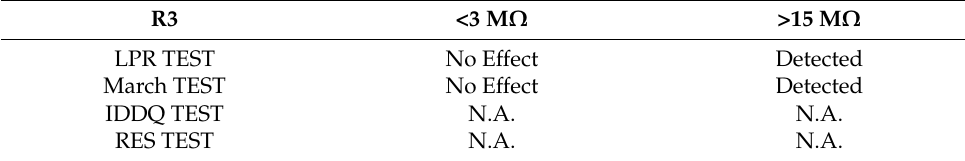
Table 7. Summary of the effectiveness of the different test methods with respect to R3. R3 <3 M